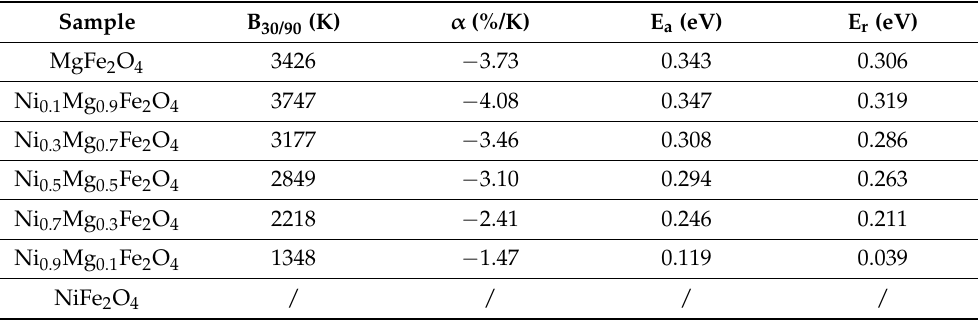
Table 3. Material constant (B 30/90 ), temperature sensitivity ( α ), activation energy for conduction (E a ) and activation energy for the relaxation process (E r